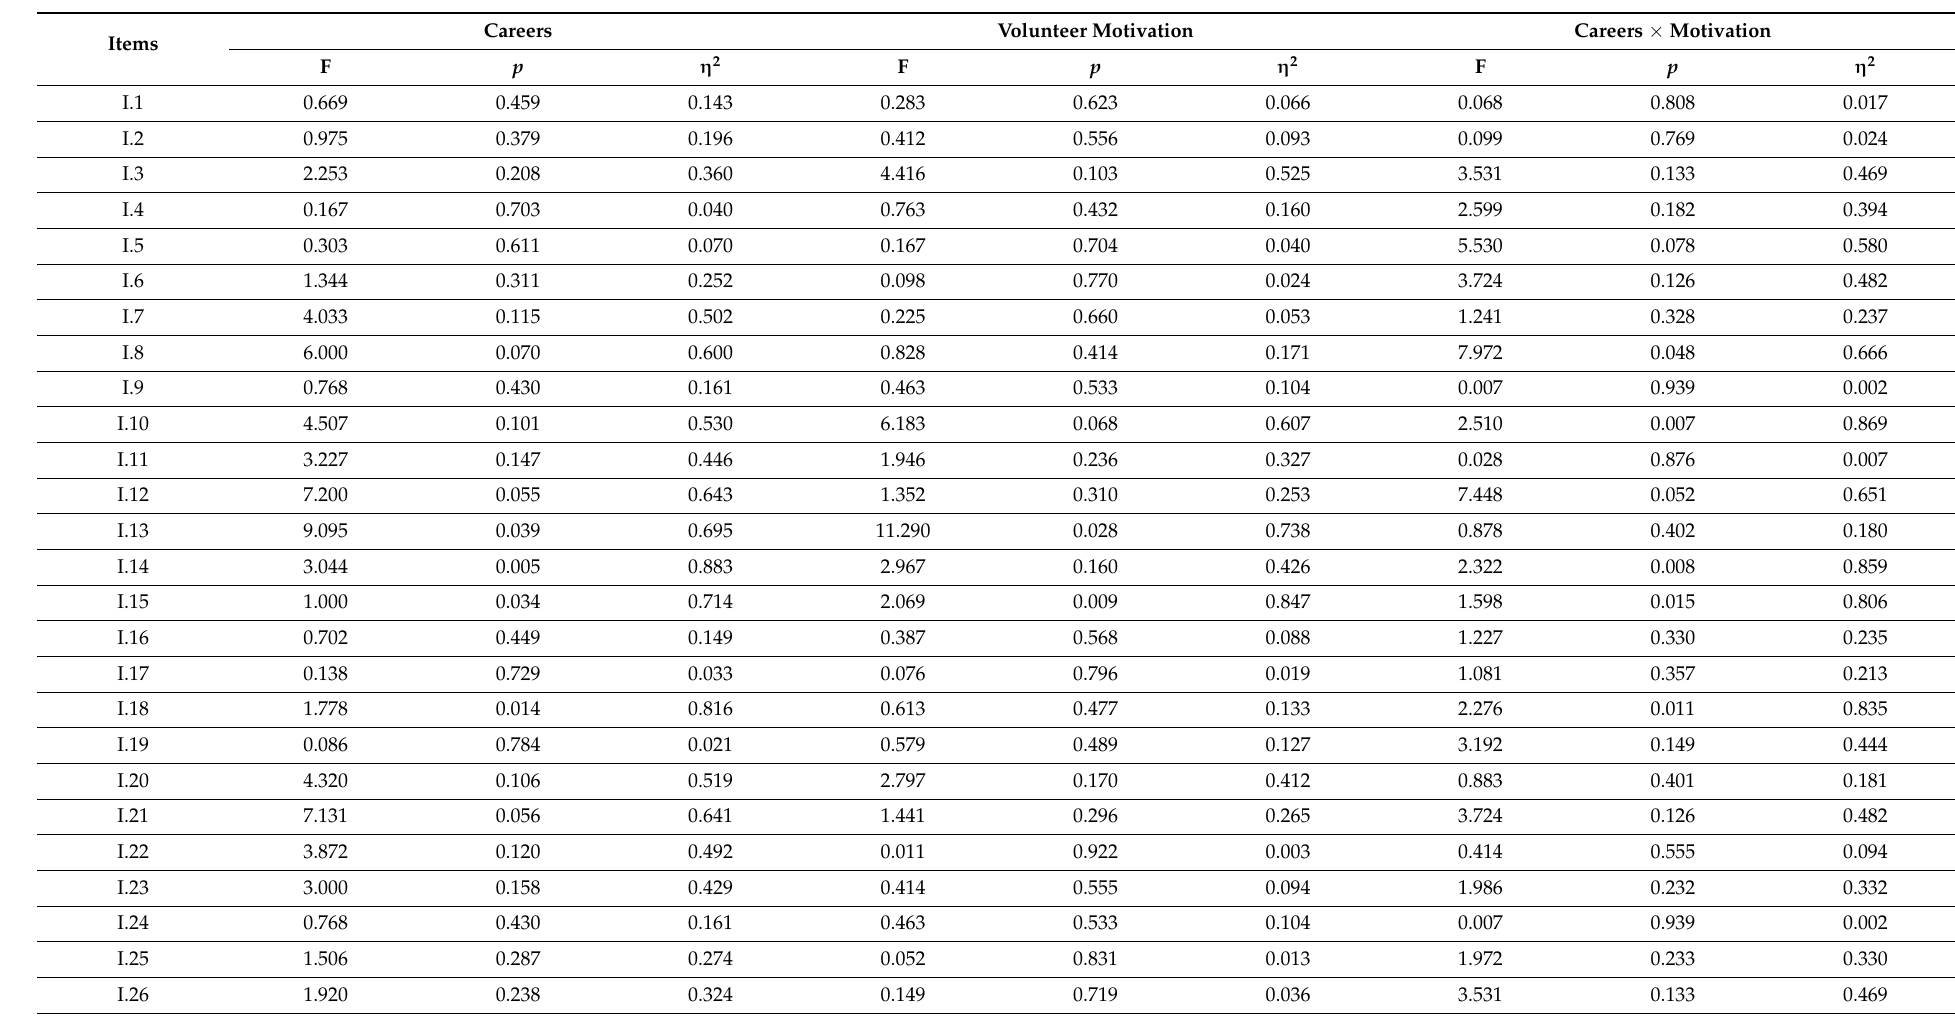
Table A1. ANOVA and effect size ( η 2 ) results of promoting social well-being through participation in volunteering using the volunteer motivation and field of study